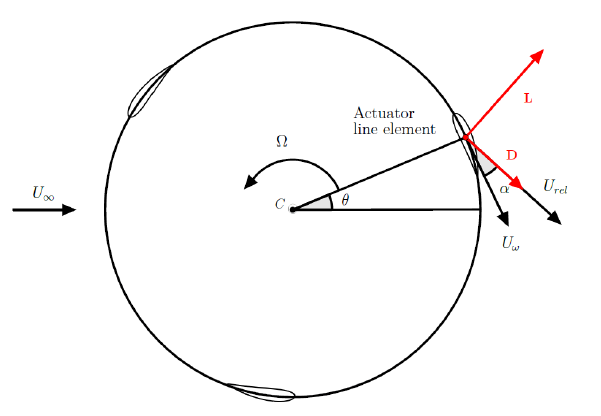
Figure 2. Actuator line scheme with: U ∞ the upstream velocity, Ω the rotational speed, θ the angular position, C the center of rotation, U ω the tangential velocity, U rel the relative velocity, α the angle of attack, L the lift force, and D the drag